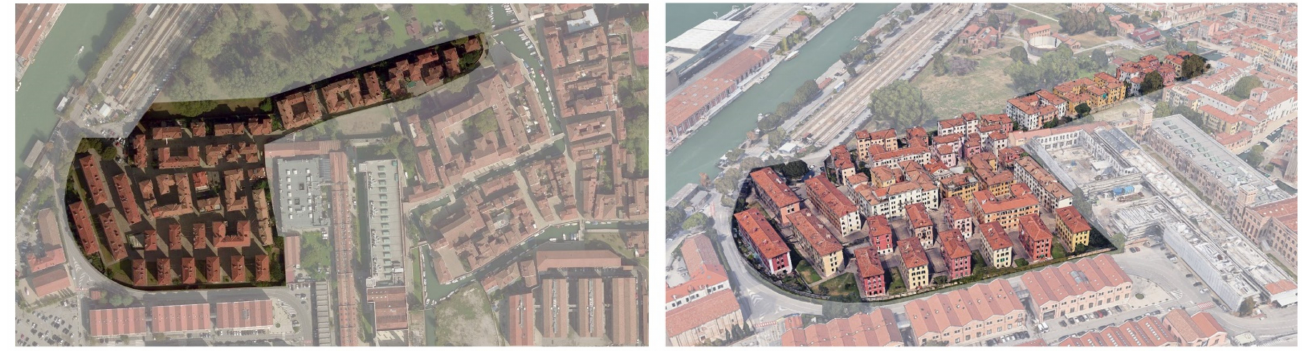
Figure 2. Satellite view and 3D visualization of Santa Marta district in